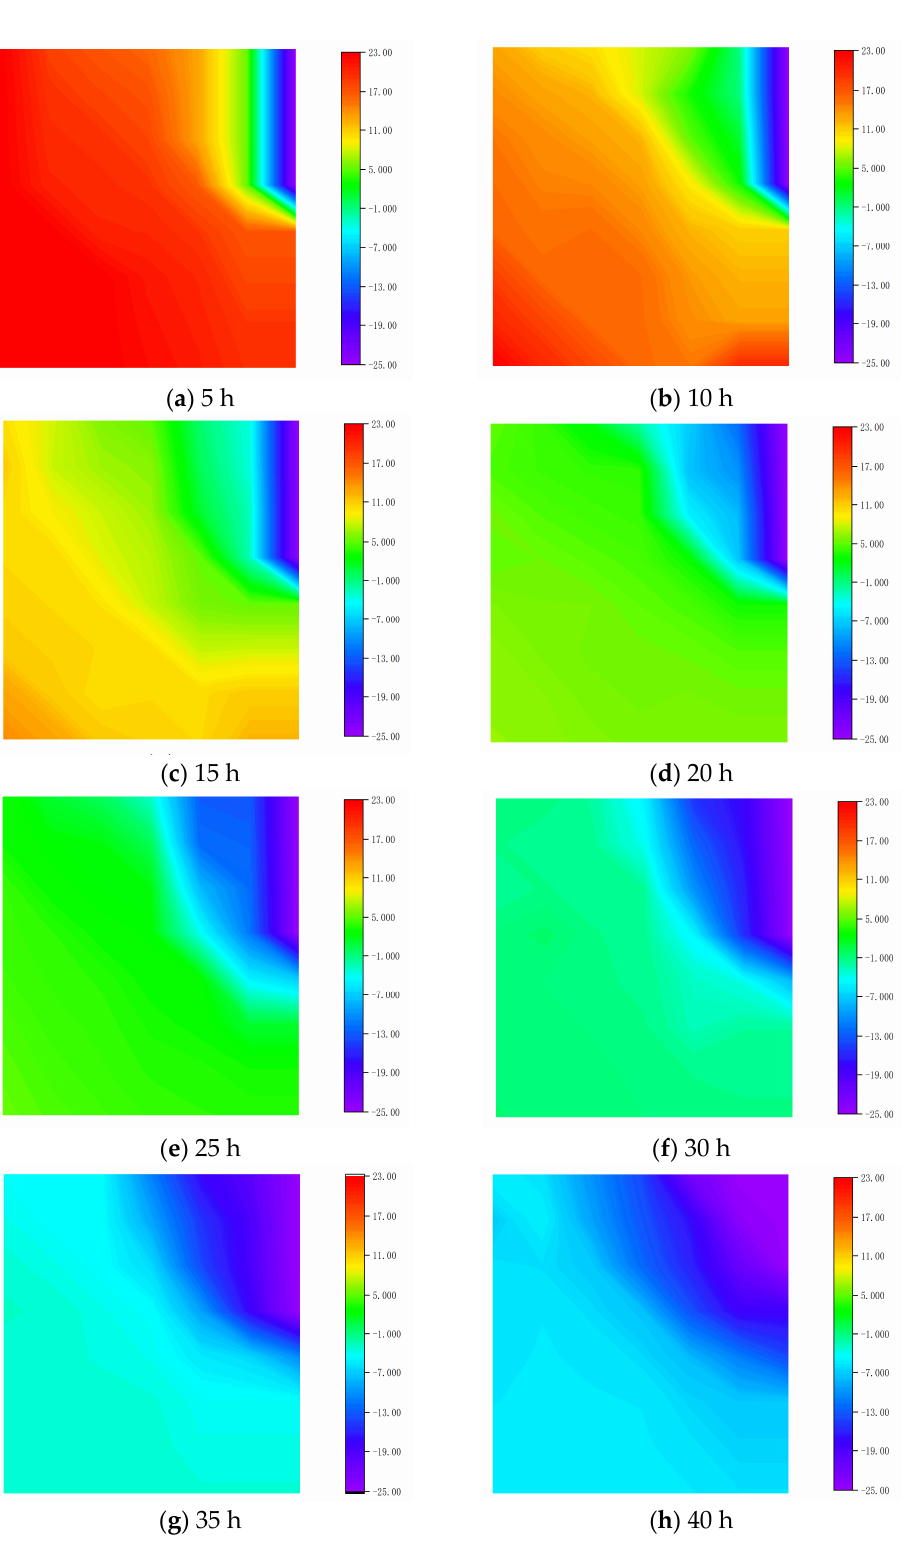
Figure 9. Cloud maps of soil temperature at different freezing times.